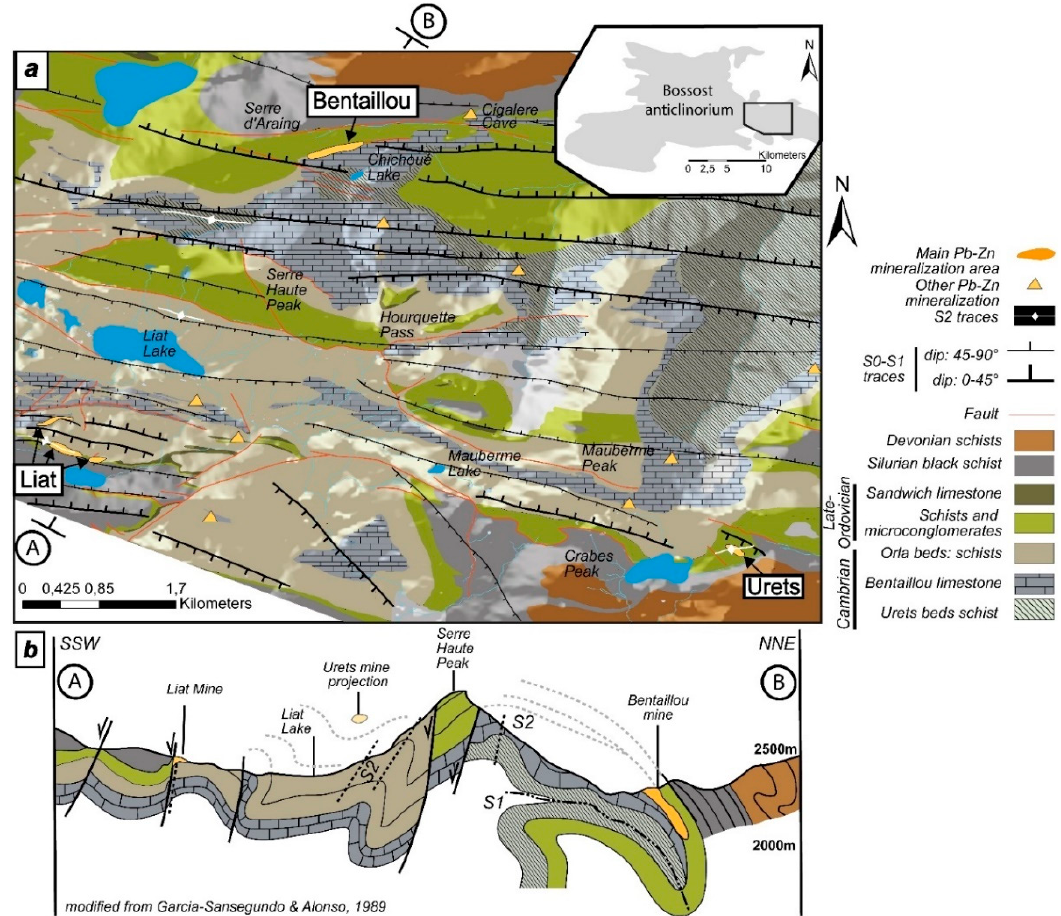
Figure 3. ( a ) Structural map of the Bentaillou-Liat-Urets district based on field study and BRGM/IGME geological maps. Location in Bossòst anticlinorium is indicated in the small sketch map (see also location on Figure 2a); ( b ) Structural NNE-SSW cross-section of the Liat-Bentaillou area. Location of the cross-section is indicated in the Figure 3a (modified from Garcia-Sansegundo and Alonso [56]). Note presence of Pb-Zn mineralization at rock competence interface and close to F1 fold hinge in Bentaillou mine.